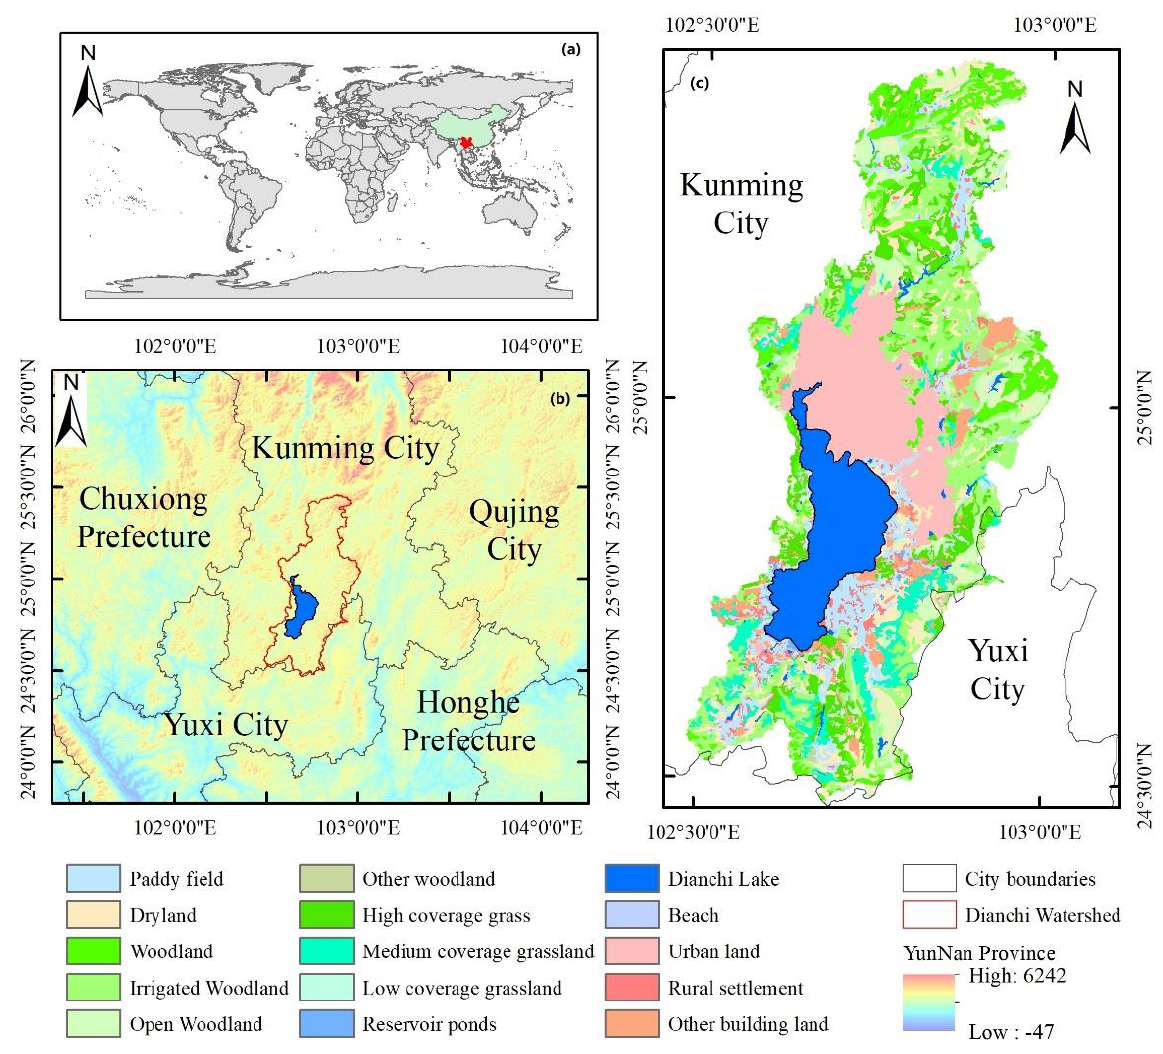
Figure 1. Overview of the study area: ( a ) shows Yunnan Province from a global perspective, ( b ) shows the DEM topographic information of the Dianchi Lake Basin, and ( c ) shows the land-use information for the Dianchi Lake Basin in 2018. A positive sign indicates a positive value above the earth level in ( b ) and a negative value below.